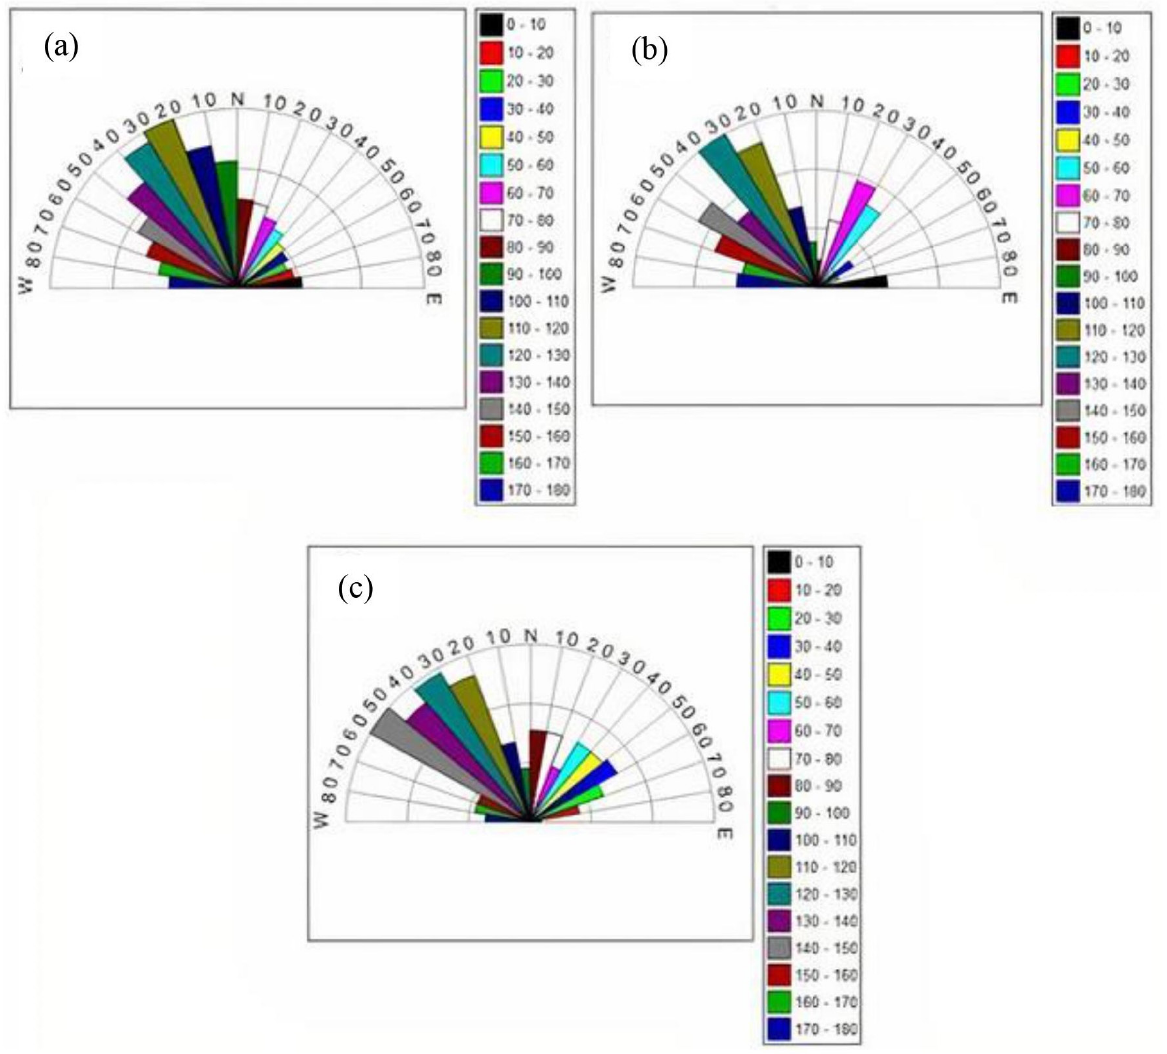
Figure 12. Rosette diagrams of absolute frequency of the linear features extracted (a) automatically on the orthomosaic generated by UAV; (b) manually on the orthomosaic generated by UAV; (c) manually in the shaded relief